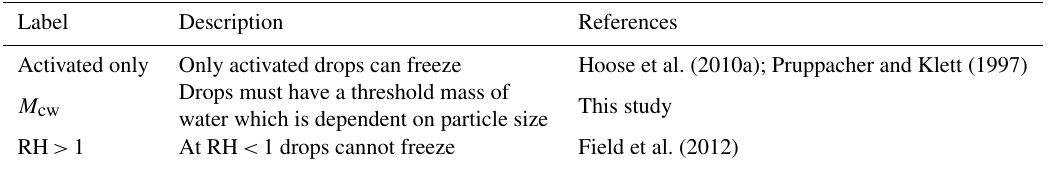
Table 1. Table describing the different criteria for heterogeneous freezing used in this study. Once the criteria has been achieved, freezing is determined by the value of n s (T ) and the surface area of the